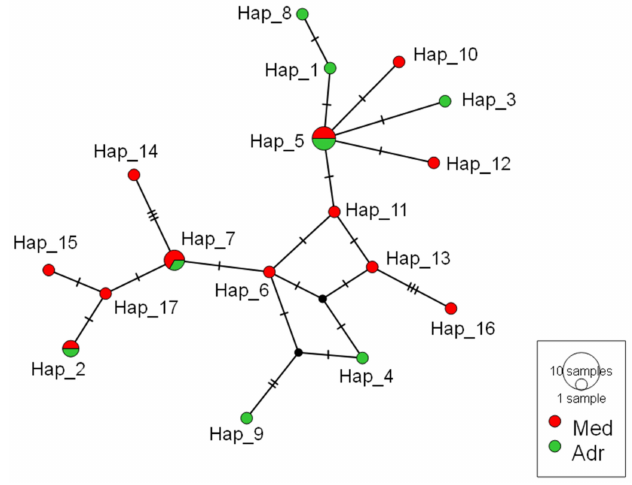
Figure 8. Haplotype network of mtCOI sequences of Calappa granulata from the Mediterranean and Adriatic Sea (24 sequences, alignment 512 bp long) constructed using the median-joining distance method. The size of each circle is proportional to the number of sequences belonging to each haplotype and short lines depict the number of mutations between haplotypes. Black spots represent missing haplotypes.